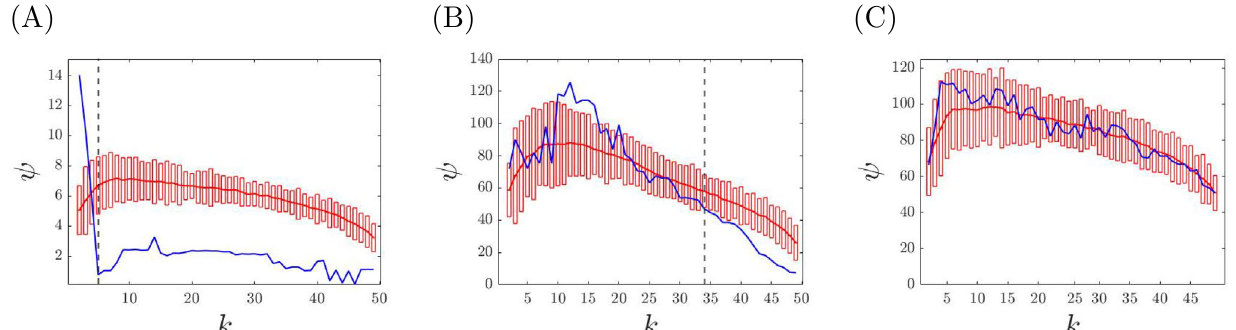
Figure 4. We plot the correction cost (blue curve) with statistical significance (red bars) and the mean of the randomized correction cost (red curve) as described above. ( A – C ) Synthetic network depicted in Fig.